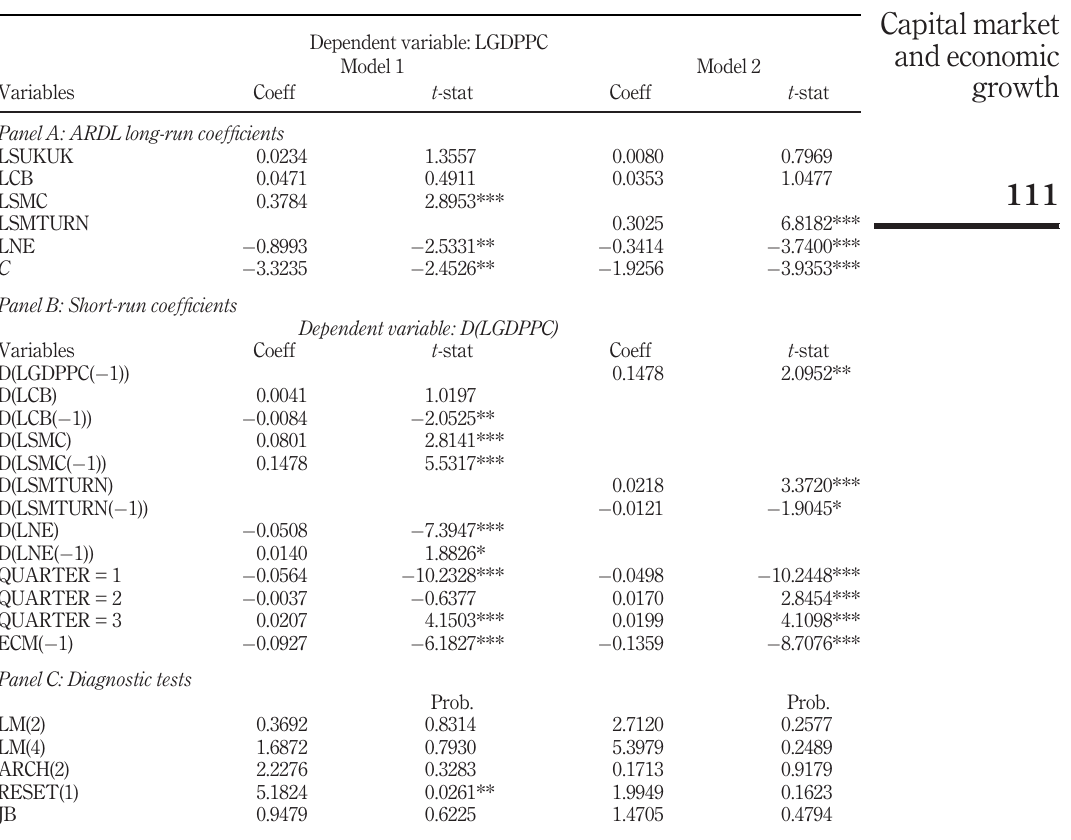
Table 5. The long-run